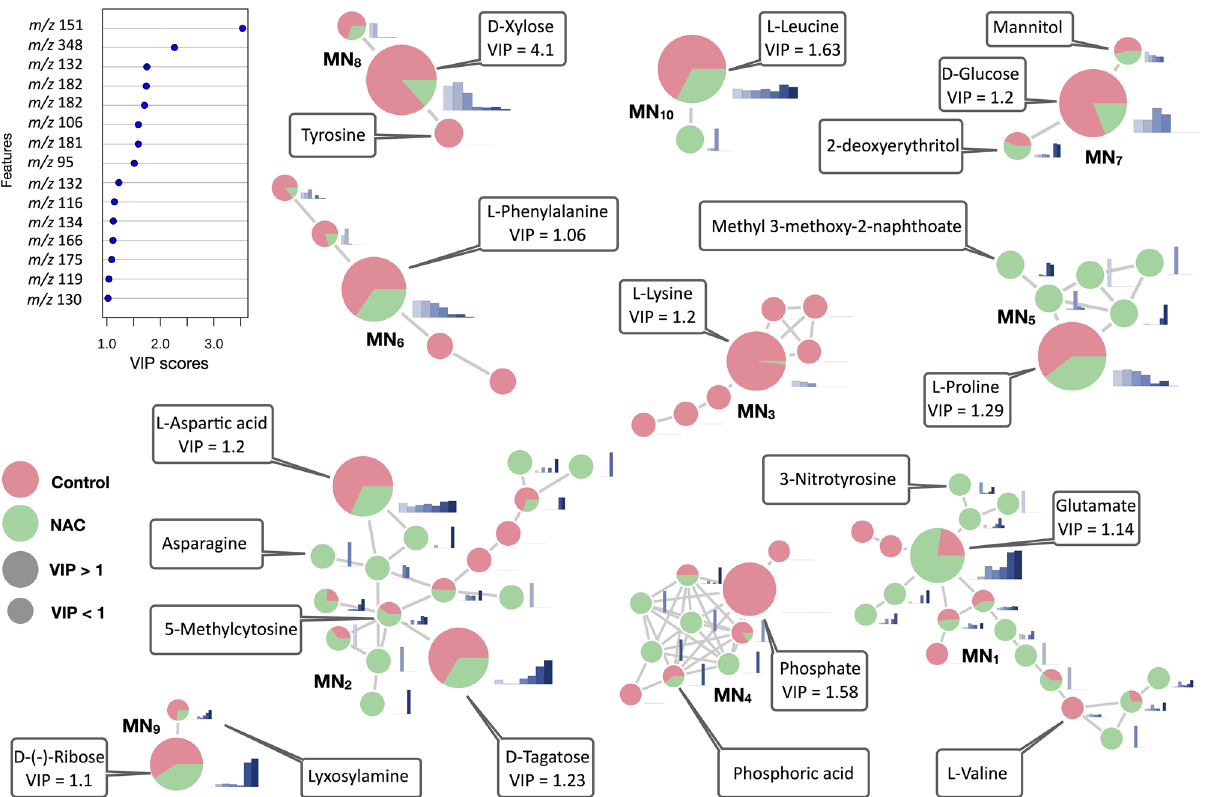
Figure 6. Selected clusters (MN 1 -MN 10 ) from the statistically informed molecular network. VIP values greater than 1 (as seen in VIP plot) from the OPLS analysis were integrated in the molecular network and were differentiated through the node size. Larger nodes indicate features with VIP values greater than 1. Annotation of compounds was performed by comparison against Global Natural Products Social Molecular Networking spectral libraries. Green or rose indicate the relative mass signal intensity in NAC treatment and untreated control group, respectively. The bar chart next to the node in blue represents the mean relative intensity of the mass signal at times 0, 1, 2, 4, 6, 12, and 24 h of the NAC treatment group. The name of the identified metabolites with cosine > 0.75 is given in the